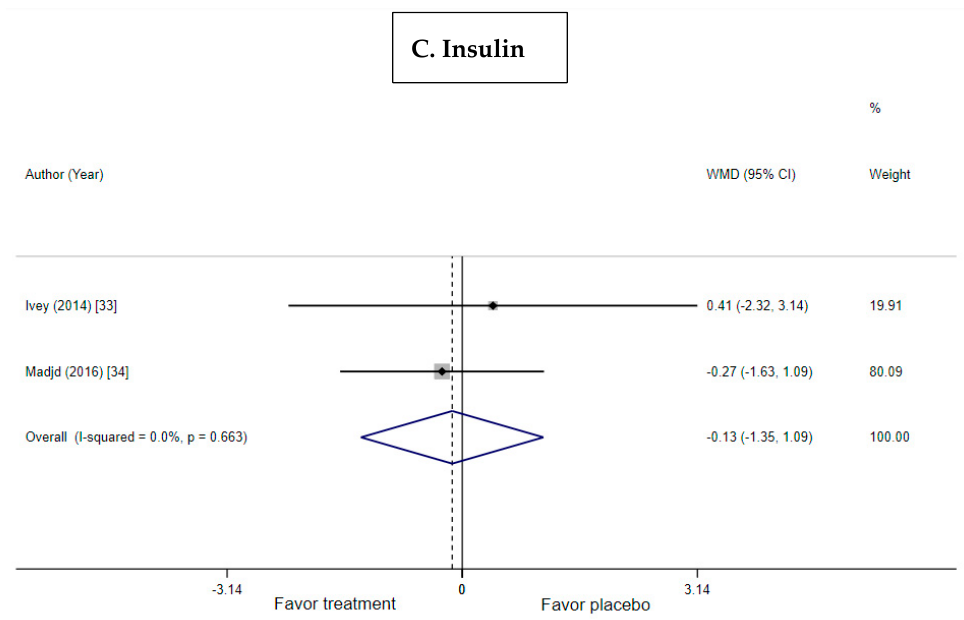
Figure 5. Forest plots for the effect of probiotic yogurt in obesity on ( A ) HbA1c, ( B ) FBG, and ( C ) insulin compared with the control in pooled analysis. T2D insulin data were only available in a single trial precluding the meta-analysis.